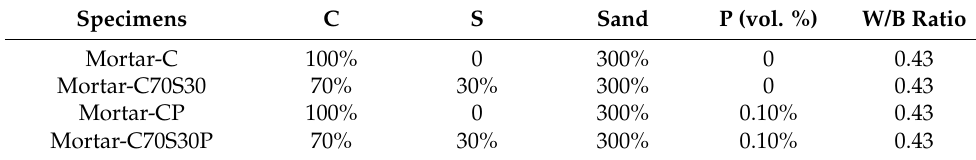
Figure 1. The mineral phase composition of cement and slag powder.